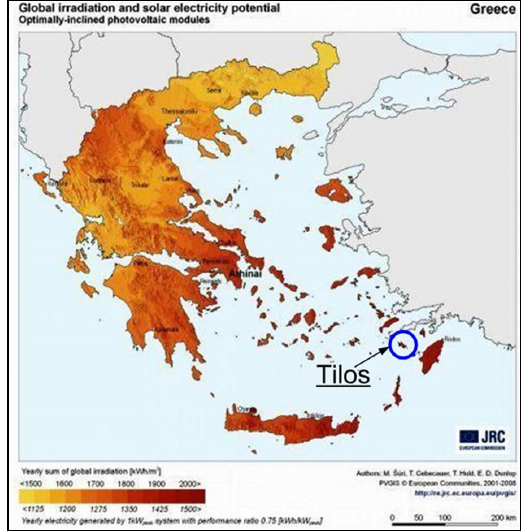
Figure 11. Tilos island location.